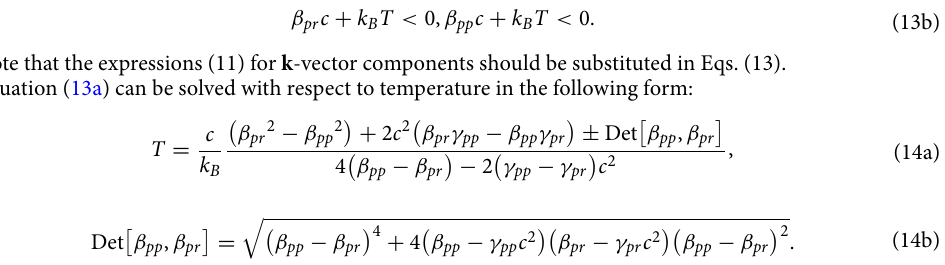
The signs “ ± ” in Eq. (14a) correspond to two different roots, which have physical sense if correspond to T ≥ 0. These roots should further satisfy two conditions (13b). Depending on the parameters it appeared possible at least for the largest root of Eq. (14a). Since the sign of denominator in Eq. (14a) is not fixed, both signs in the numerator, + Det , are possible depending on the parameters. Hence, the number